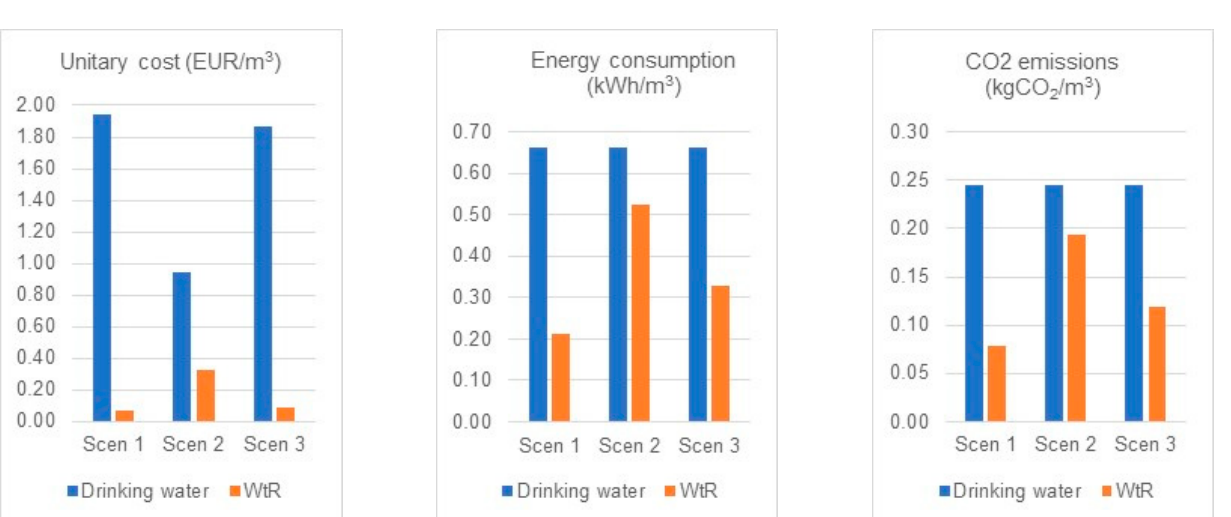
Figure 8. Average exploitation costs, energy and CO 2 emissions associated with WtR consumption. An analysis of the unitary costs, energy and CO 2 emissions was also conducted, and the results are presented in Figure 9. The unitary cost associated with the supply with WtR is considerably lower than the traditional supply with drinking water, especially in the scenarios with golf course irrigation (1 and 3), due to the low transportation cost. The unitary energy consumption and CO 2 emissions are also lower when using WtR, which can be explained by the lower need for additional treatment applied to this solution.